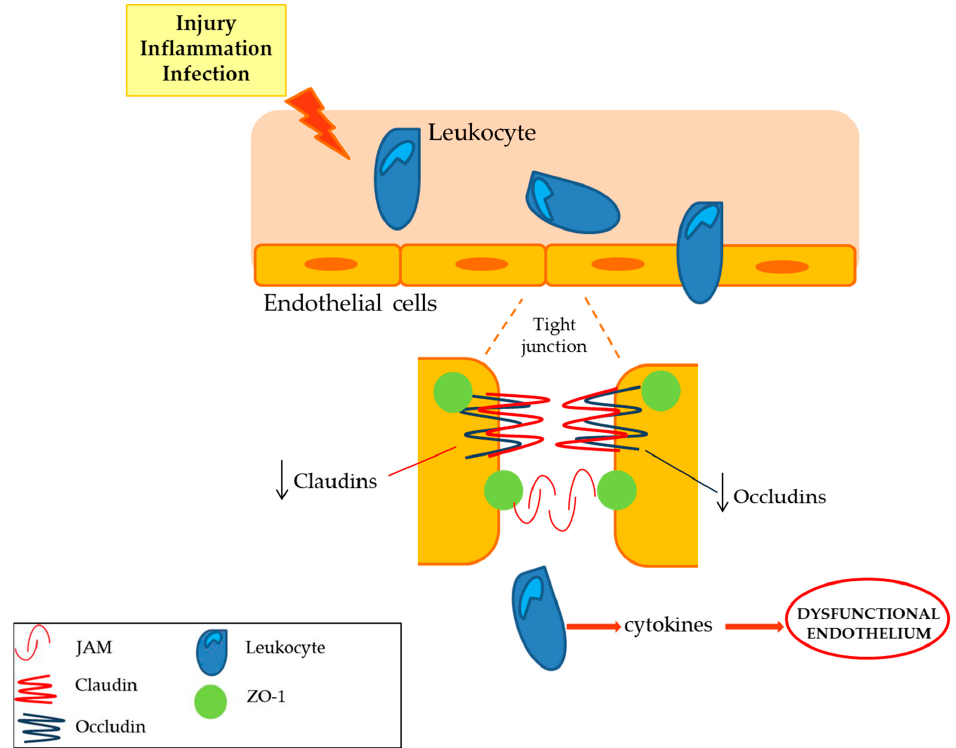
Figure 5. Endothelium dysfunction and leukocytes infiltration. During pathological conditions, such as inflammation, infection, and injury of peripheral nerve, an alteration of endothelial intercellular junction proteins occurs. A reduction of tight junction proteins, such as claudins and occludins, determines a leukocytes infiltration.